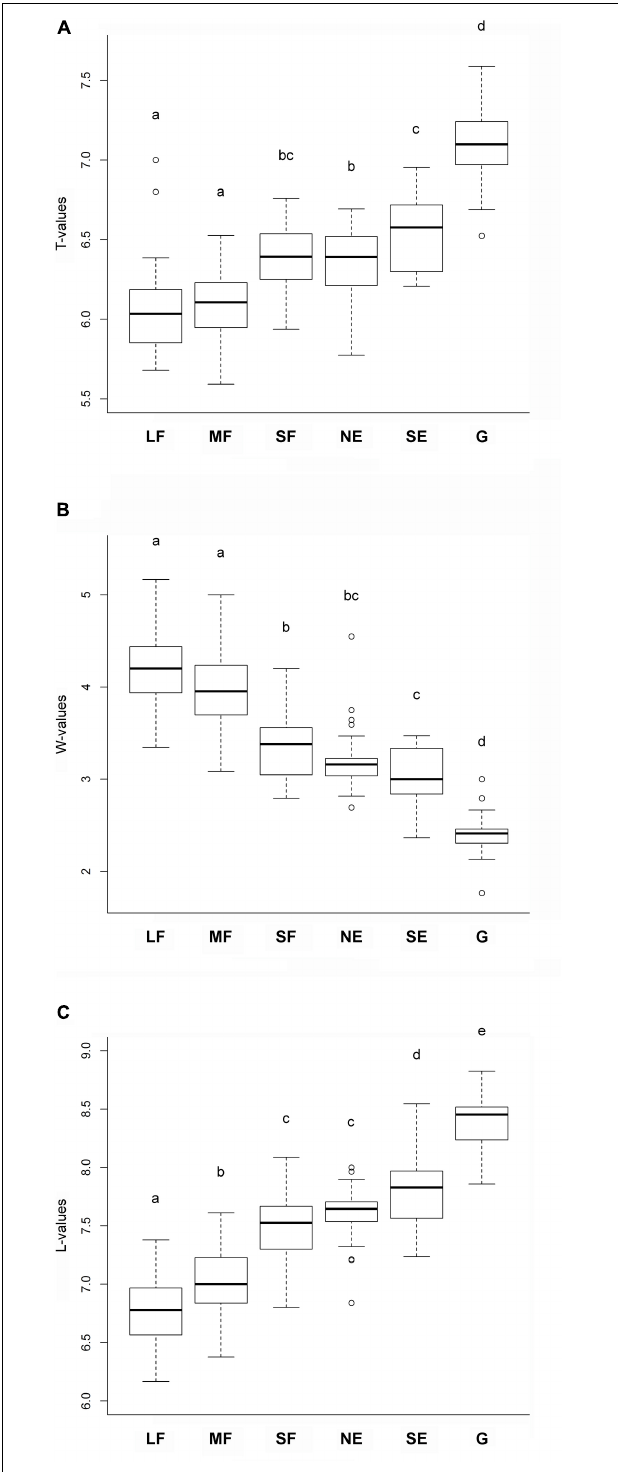
FIGURE 3 | Mean ecological indicator values for (A) temperature, (B) soil moisture, and (C) light availability for the studied habitats. The habitats not sharing a letter are significantly different. LF, large forest patches; MF, medium forest patches; SF, small forest patches; NE, north-facing edges; SE, south-facing edges; G,